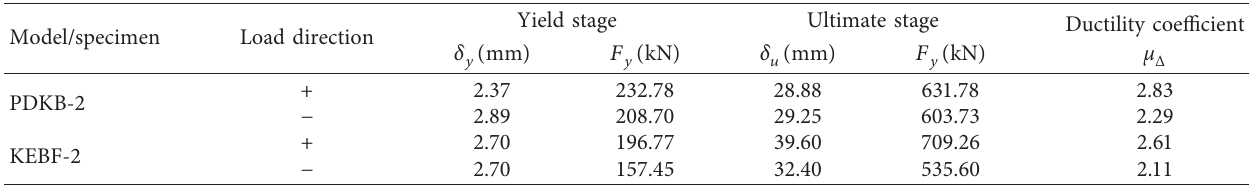
Figure 33: Comparison of hysteresis curves and skeleton curves of PDKB-2 and KEBF-2. Table 16: Comparisons of capacity and ductility by experiment and by